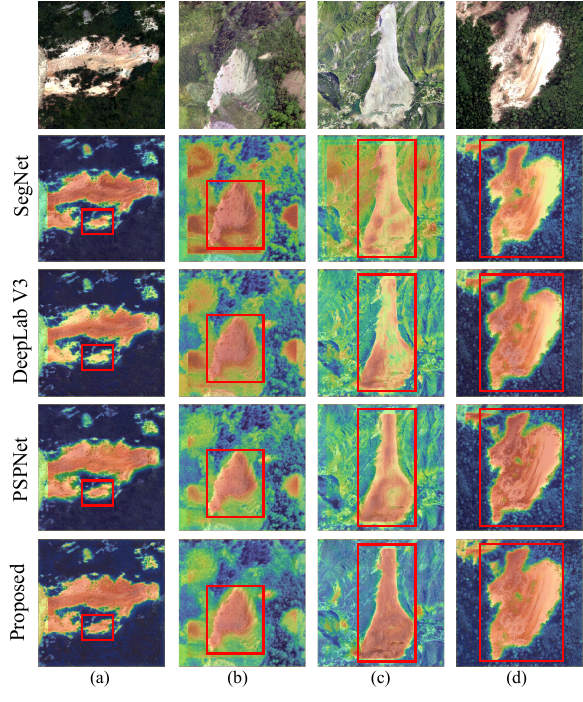
Figure 5. Comparison diagram of splitting results.